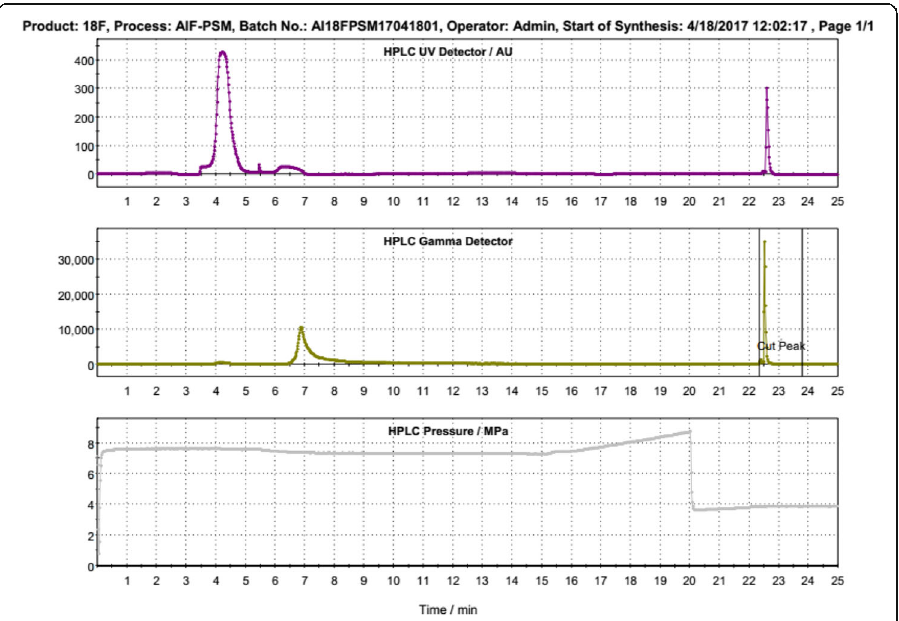
Fig. 4 Raw HPLC profile from the FXFN module (upper: UV — 280 nm, medium: gamma-ray and bottom the